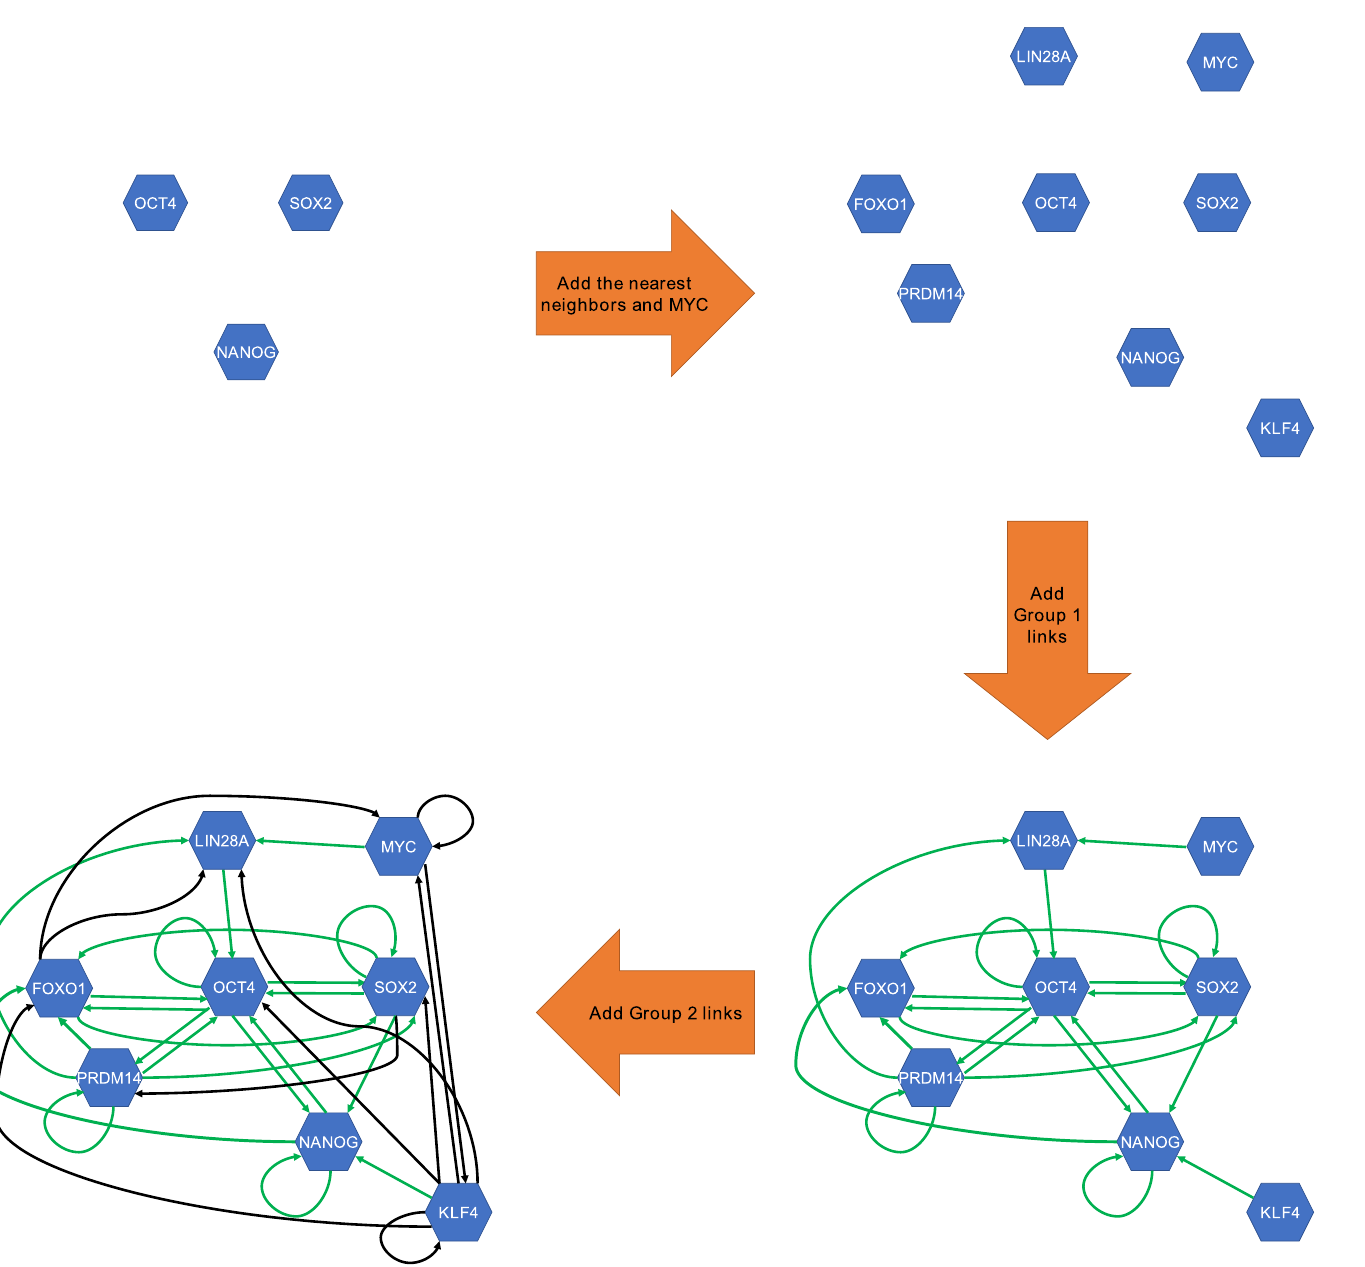
Fig 6. Construction of the starting network. Using a small representative subset of nodes, the figure explains how the starting network was constructed. We started from OCT4, SOX2, and NANOG and built the network around these TFs by adding their experimentally verified direct targets and regulators and MYC (see the text for details). We then connected the nodes of the network by adding regulatory links in two steps. First, the experimentally verified links (Group 1; colored in green) were added. These included the links between OCT4/SOX2/NANOG and their targets/regulators as well as other experimentally verified links that we found. We then added a large number of inferred links (Group 2; colored in black) based on a database developed by Marbach et al.